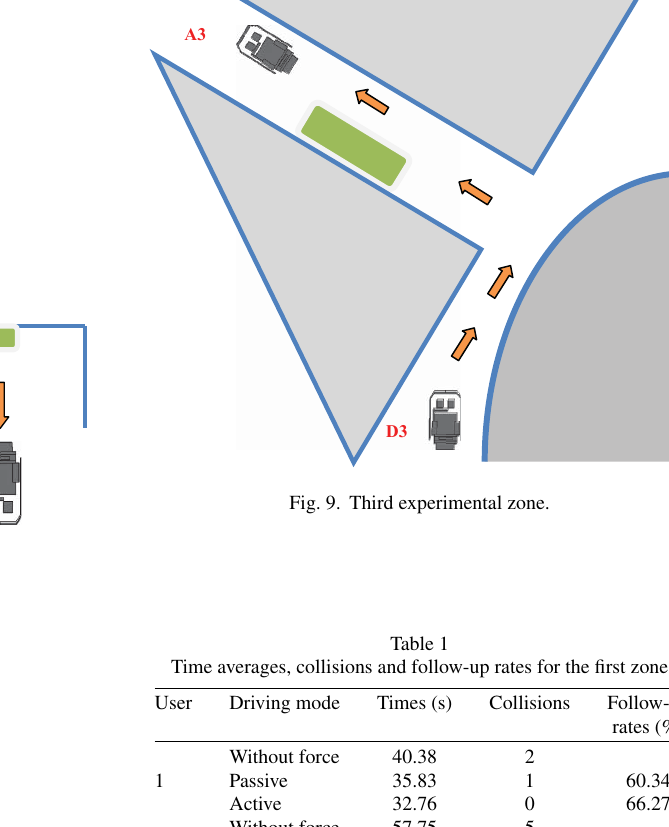
Fig. 7. First experimental zone.